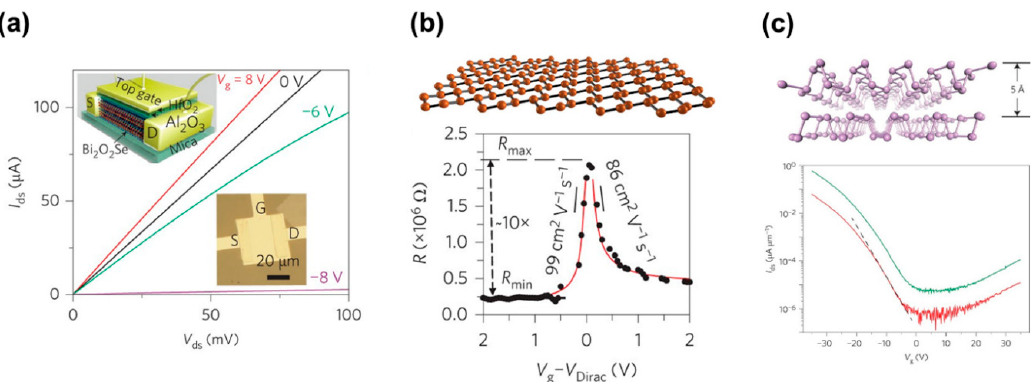
Figure 4. ( a ) Output curves obtained from a top-gated 6.2 nm-thick Bi 2 O 2 Se channel FET and optical microscopy image of a top-gated device. Reprinted with permission from ref. [72]. Copyright (2017) Nature Publishing Group. ( b ) Buckled honeycomb lattice structure of silicene and R vs. (Vg—Vdirac) of silicene channel FET devices. Reprinted with permission from ref. [73]. Copyright (2015) Nature Publishing Group. ( c ) Atomic structure of black phosphorus and transfer curves of 5 nm-thick phosphorene FET device. Reprinted with permission from ref. [77]. Copyright (2014) Nature Publishing Group.